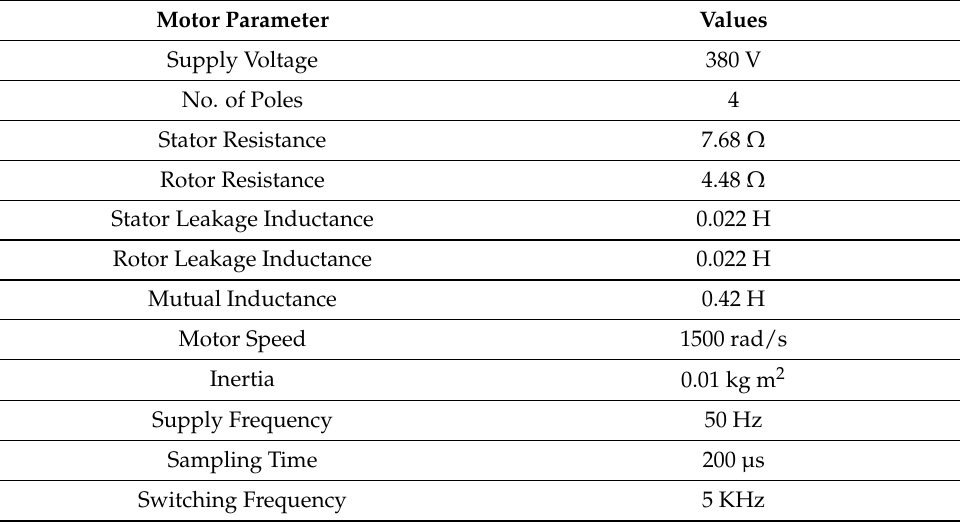
Table 8. Parameters of the six-phase induction